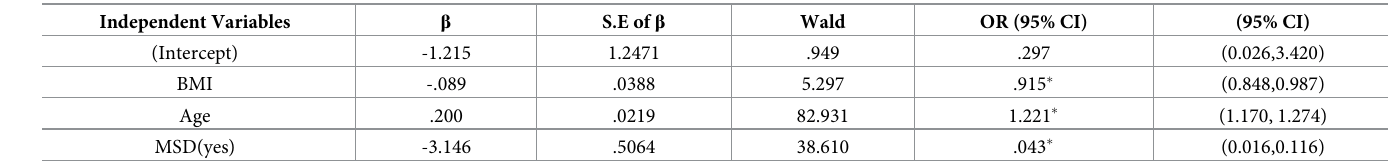
Table 6. The results of the negative binomial regression for MVPA (as a dependent variable) age, BMI, and MSD. Independent